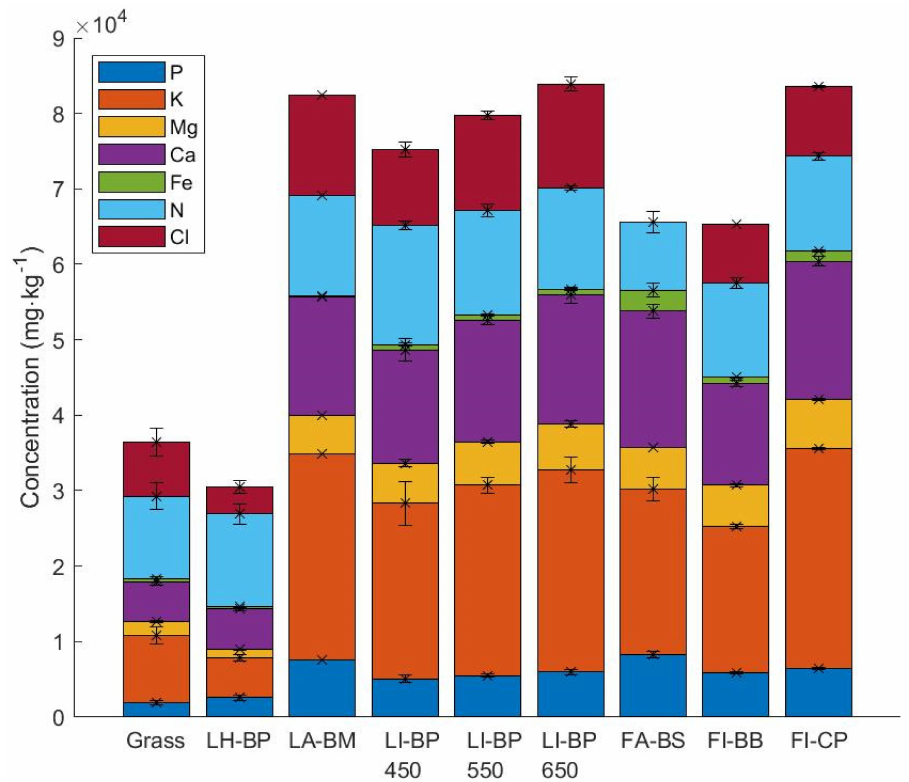
Figure 3. Concentration of various nutrients contained in the grass feedstock and biochar product. Presented are the mean values of multiple samples and the error bars mark the standard deviation of the